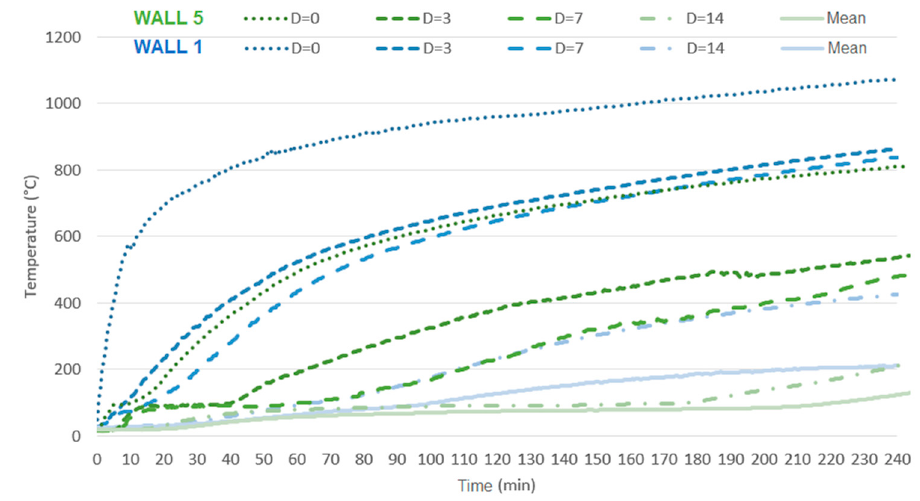
Figure 23. Influence of the addition of 25 mm of coating on the fire-exposed face.